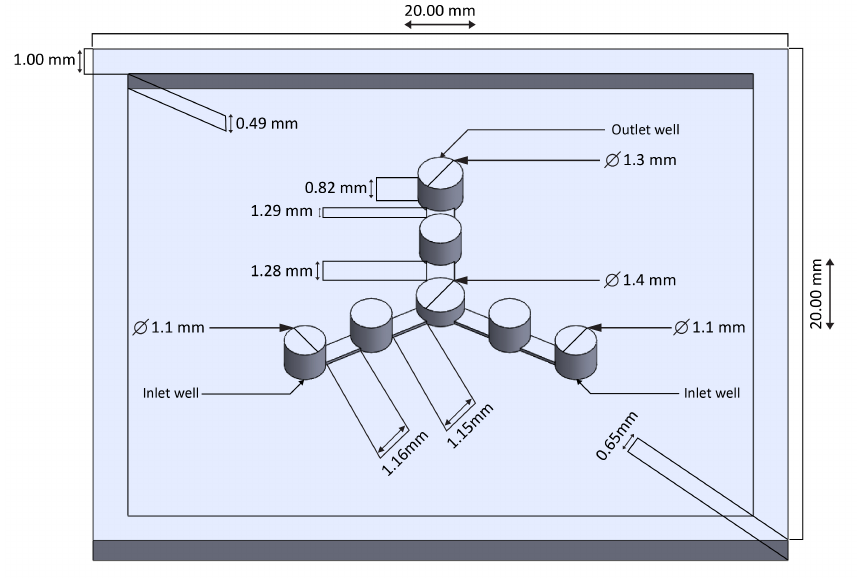
Figure 1. Using a 3D tool, geometric details of the designed 3D structure drafted to prepare a replica mold of PDMS-made microfluidic